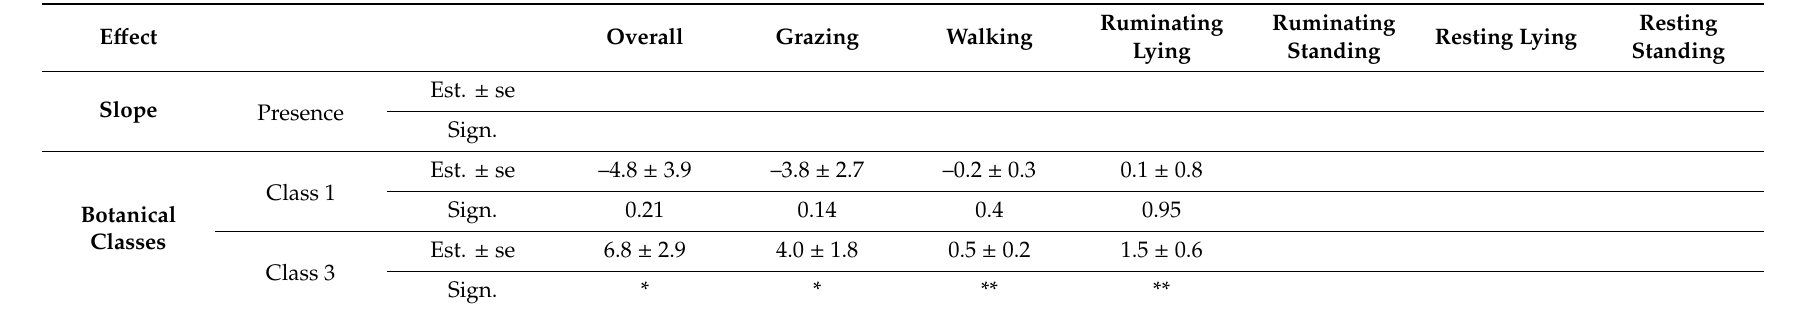
Overall Grazing Walking